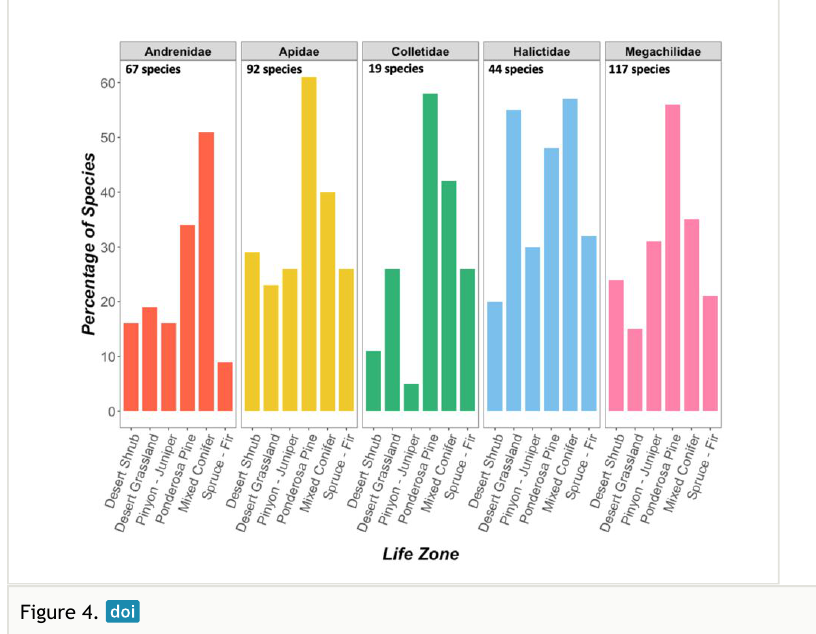
Percentage of species in a family found at each life zone (n=339 species for which we had accurate locality data to assign life zone designations). Numbers for each family sum higher than 100% because of species that occurred in more than one life